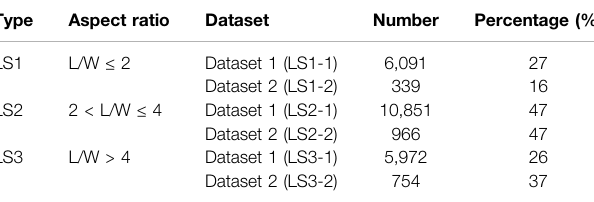
TABLE 1 | Classi fi cations of the plane morphology of